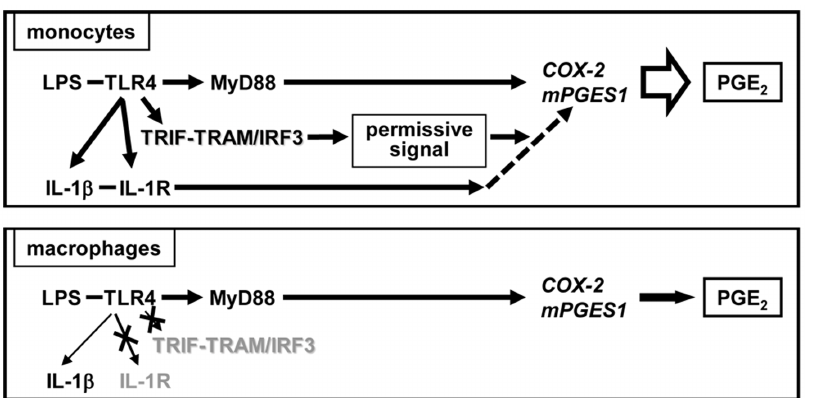
Figure 10. Model of IL-1 b dependent and IL-1 b independent pathways of PGE 2 production in human monocytes and macrophages.